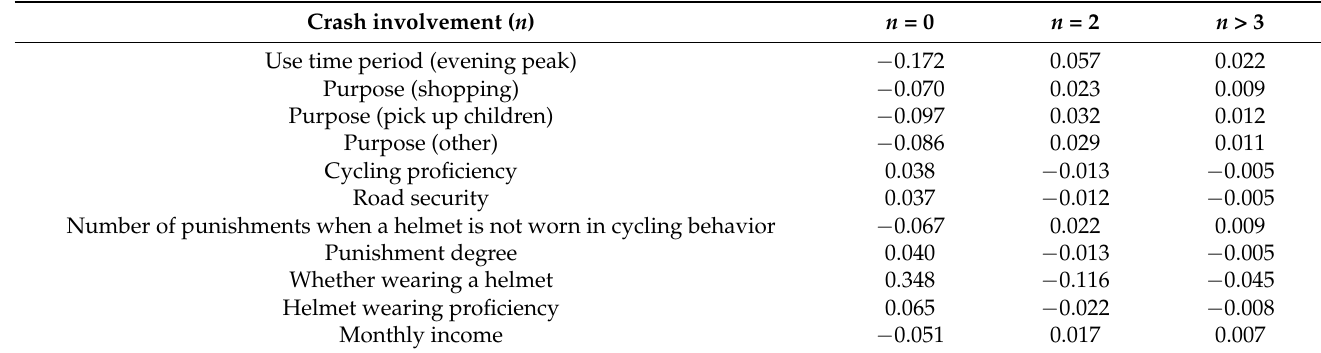
Table 6. Marginal effect of the crash involvement BOP model.